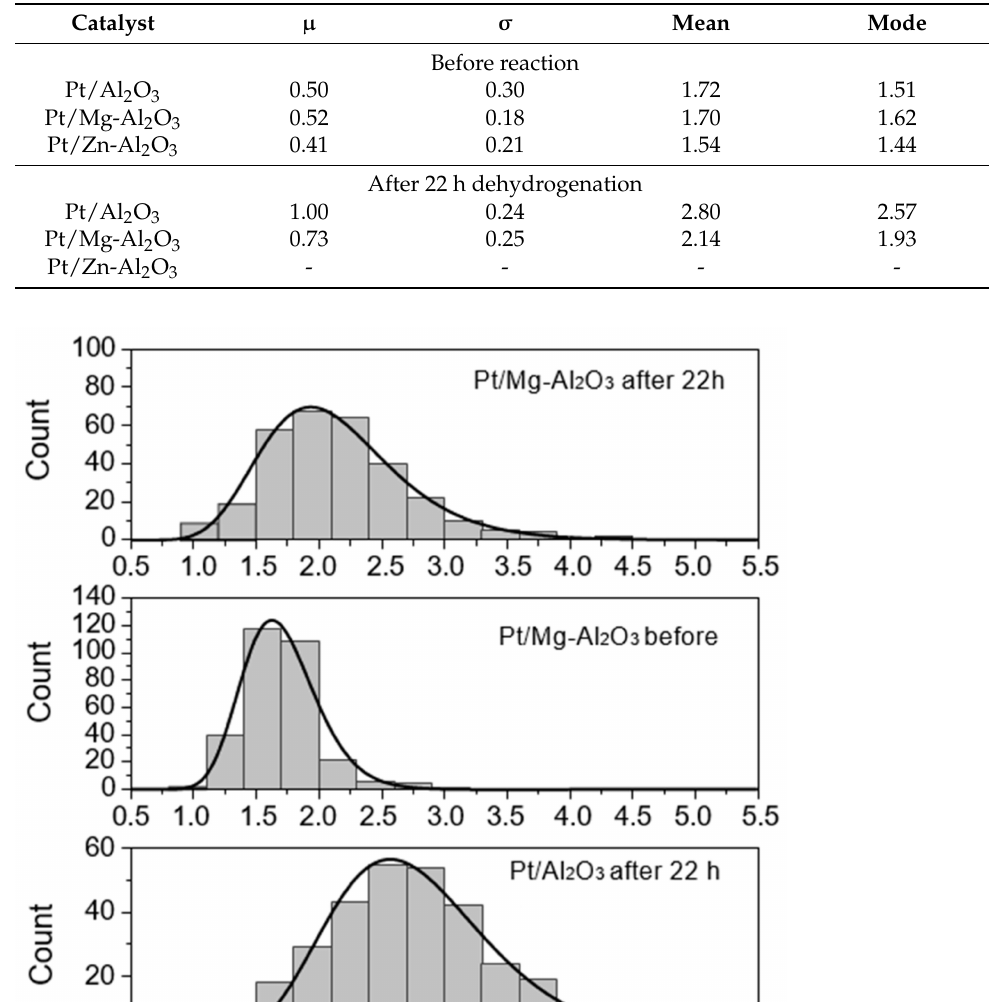
Table 6. Log-normal distribution parameters for mean and mode calculations of Pt nanoparticles obtained by transmission electron microscopy (TEM) before and after 22 h dehydrogenation reaction.